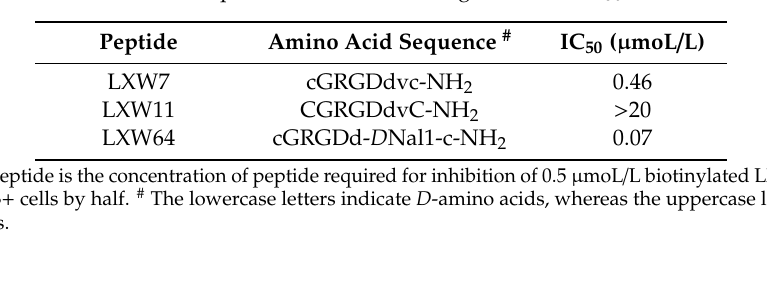
Table 1. Representative LXW analogs and their IC 50 s *.